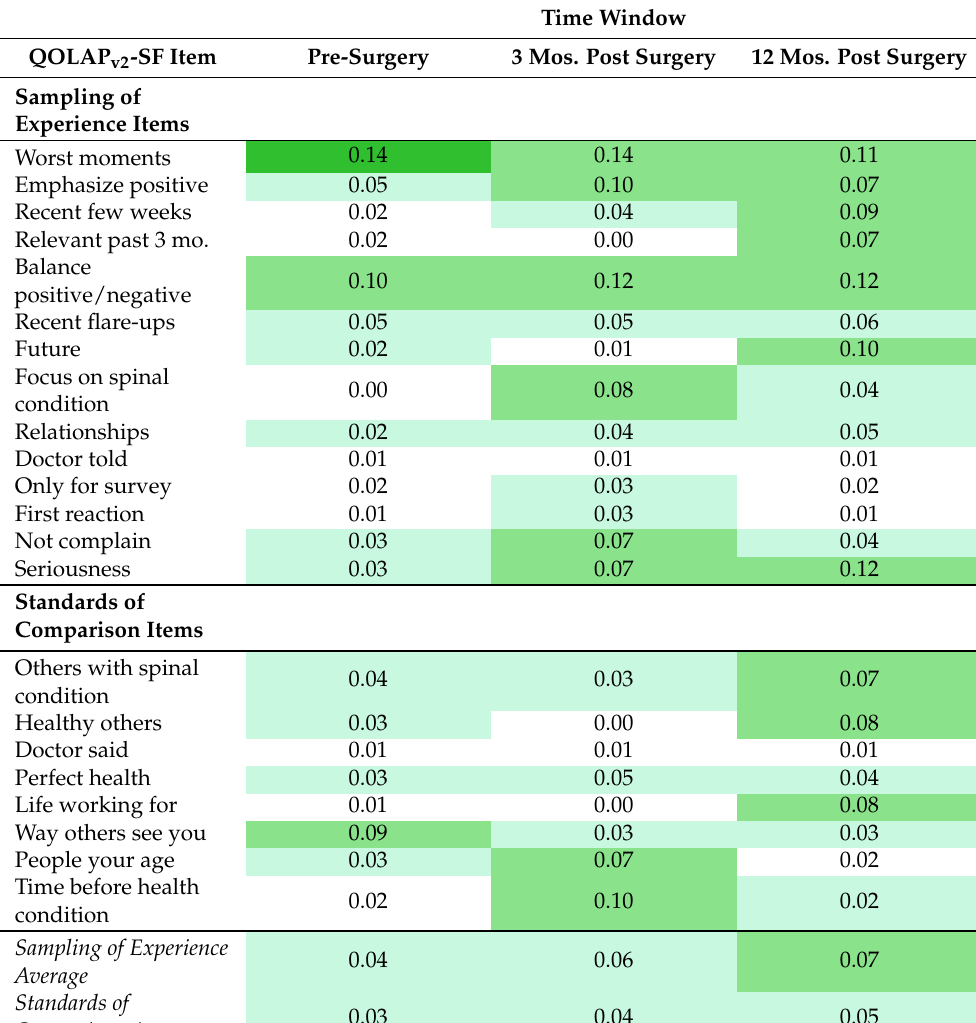
Table 3. MCS: Eta 2 in One-Way